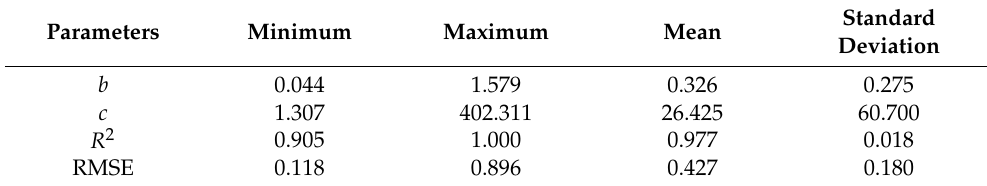
Table 6. The statistics of the estimation parameters of the cumulative distribution function of the stand diameter structure for all